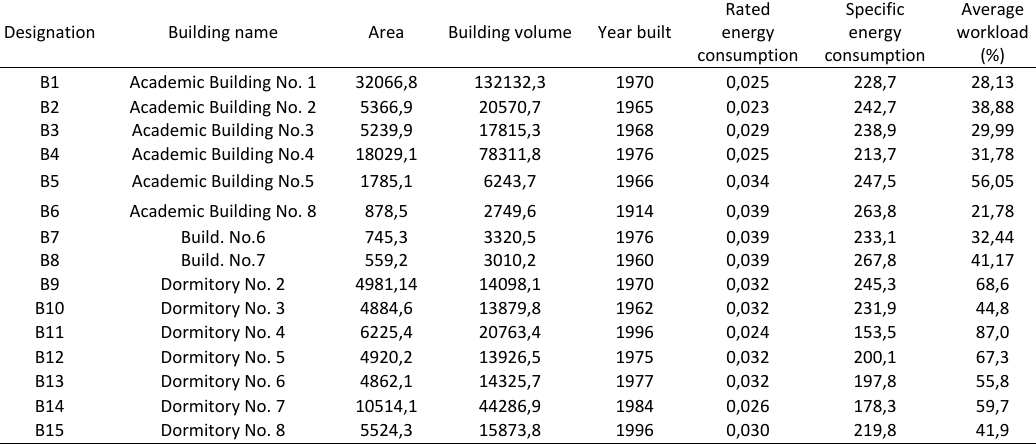
Table 2: The main buildings of the KNUTD and their technical specifications